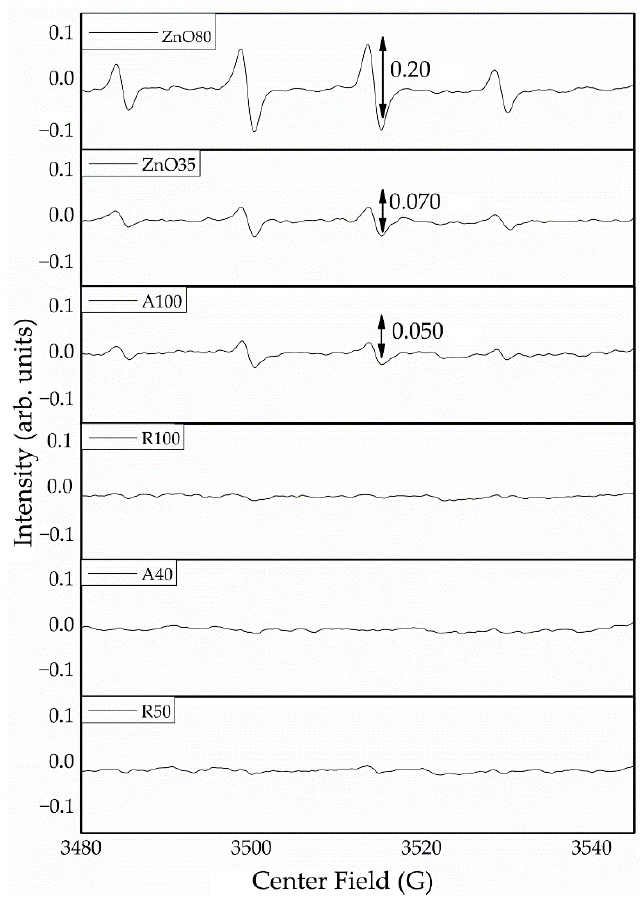
Figure 3. Intensity in arbitrary units (arb. units) of adducted hydroxyl radicals (·OH) produced by ZnO (ZnO 35 − zinc oxide 35–45 nm and ZnO 80 − zinc oxide 80–200 nm) and TiO 2 (A100 − anatase 100 nm, A40 − anatase 40 nm, R100 − rutile 100 nm, and R50 − rutile 50 nm) NPs following 30 min of irradiation, as measured using electron paramagnetic resonance (EPR) spectroscopy.